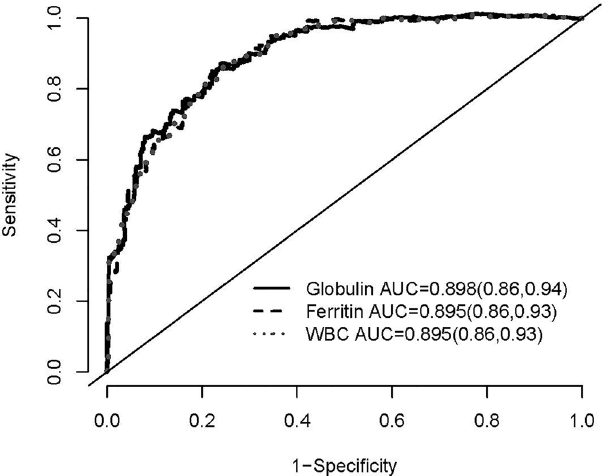
Figure 5. The area under the curve (AUC) by the Receiver Operating Characteristics (ROC) curve analysis of the 3-year all-cause mortality for variables in model 4 plus globulin, ferritin, and WBC counts, respectively. Numbers in parentheses indicate 95% confidence intervals.